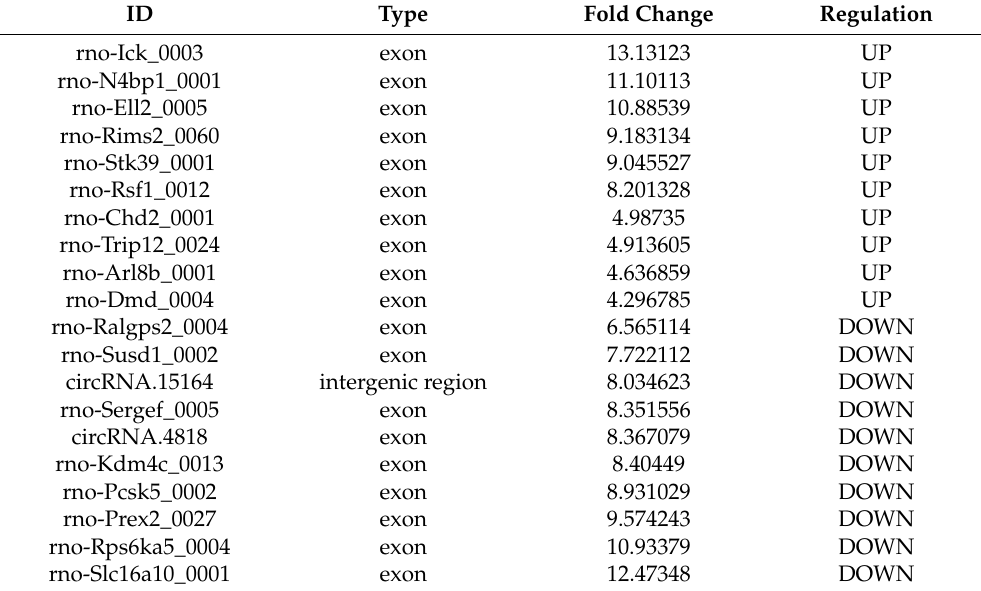
Table 2. Top 10 up- and down-regulated DEcircRNAs obtained by sequencing. ID Type Fold Change